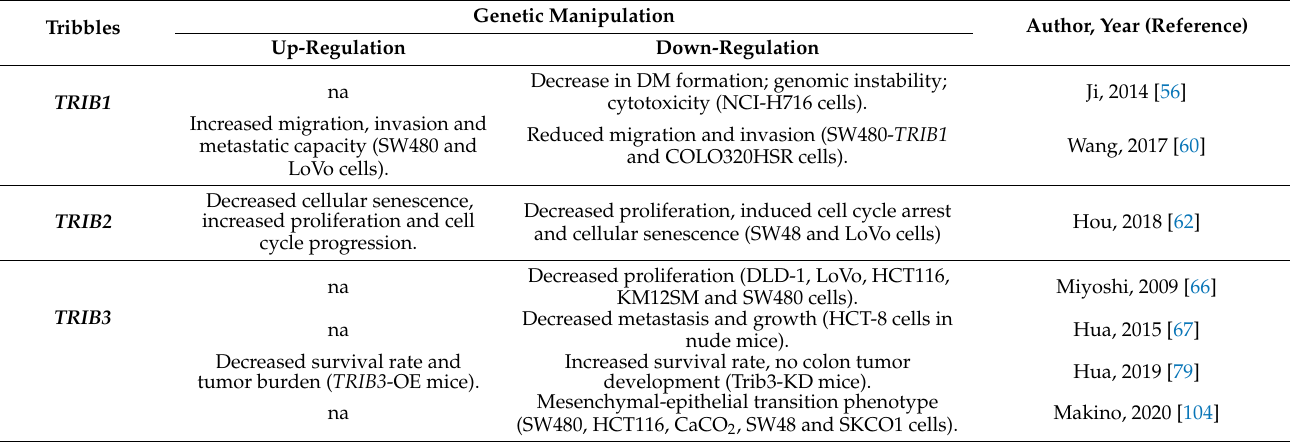
Table 3. Tribbles genetic modulation response in colon cancer. Main results obtained for cellular genetic manipulation of Tribbles is described, separately for either up- or down-regulation, and respective reference (author, year). Not applicable (na) is shown when the data was not